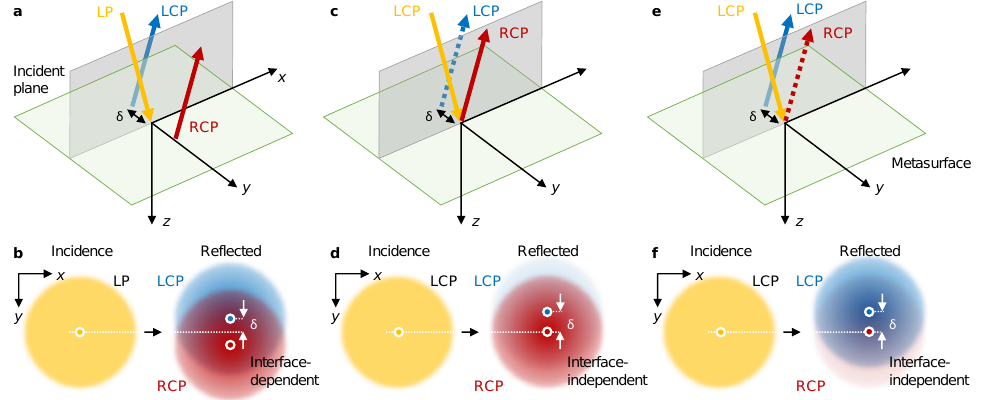
Figure 1. Schematics of the SHEL at an interface between two isotropic media and at the metasurface. LP: linear polarization. ( a ) SHEL and ( b ) beam profiles under linearly polarized incidence at the interface between two isotropic media. ( c ) SHEL and ( d ) beam profiles under circularly polarized incidence at the interface between two isotropic media. ( e ) SHEL and ( f ) beam profiles under circularly polarized incidence at the metasurface, designed to increase the intensity of the spin-Hall-shifted beam by reversing the handedness of the reflected